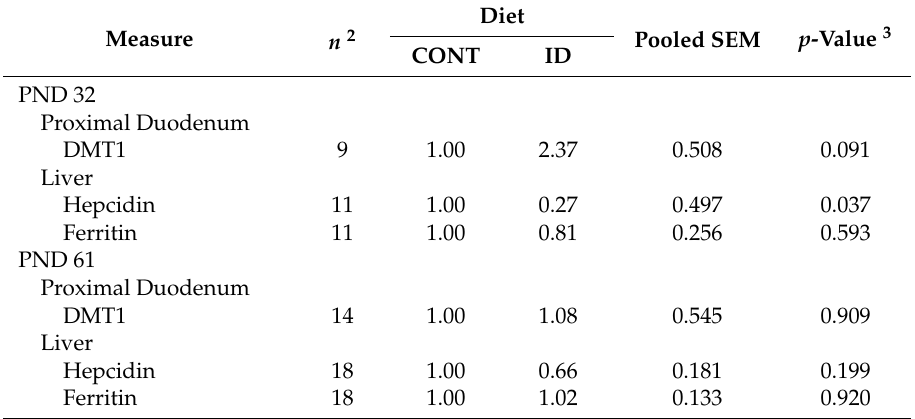
Table 4. Iron-related gene expression relative from pigs differing in early-life iron status 1